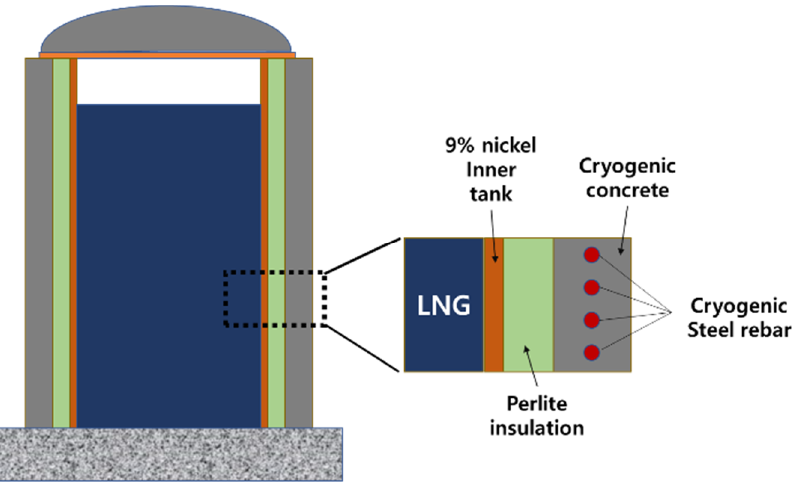
Figure 1. Full containment LNG storage tank.